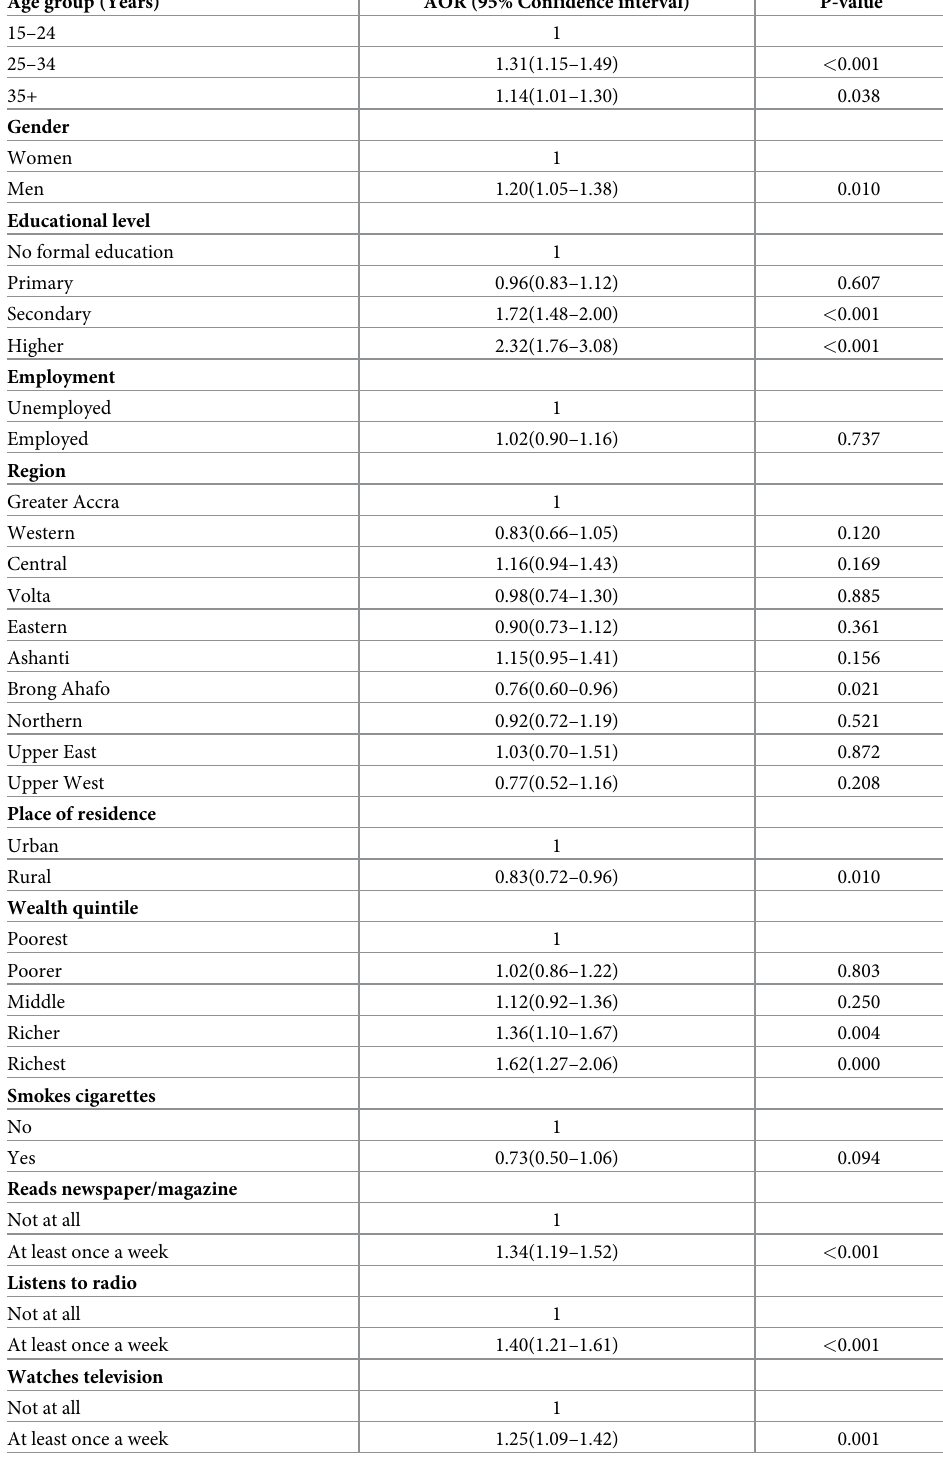
Table 3. Determinants of correct knowledge regarding tuberculosis transmission and cure in